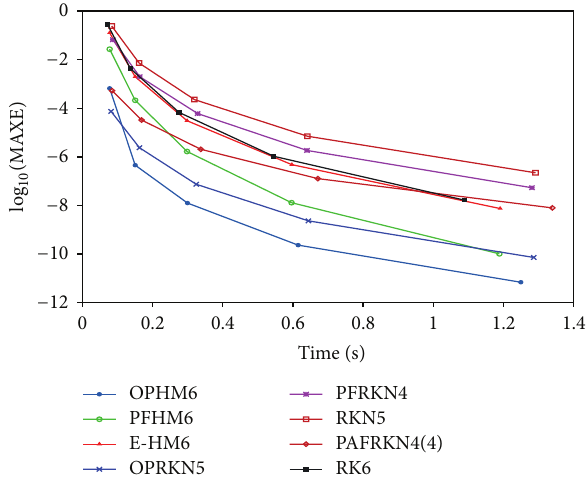
Figure 13: The efficiency curves of the optimized order six method and their comparisons for Problem 7 with 𝑡 0.125/2 𝑖 , 𝑖 = 1,...,5 .